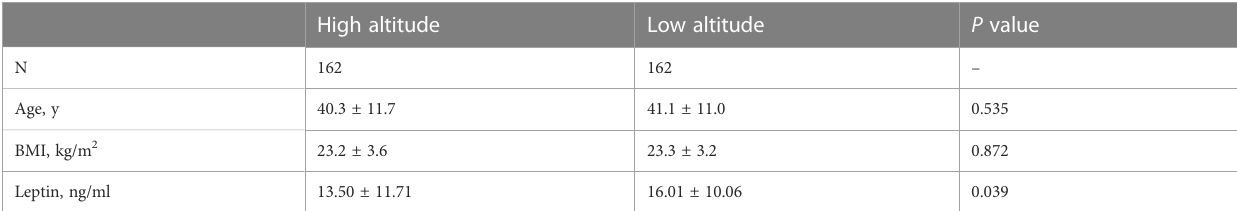
TABLE 2 Serum leptin concentrations of native women living at high and low altitude after age- and